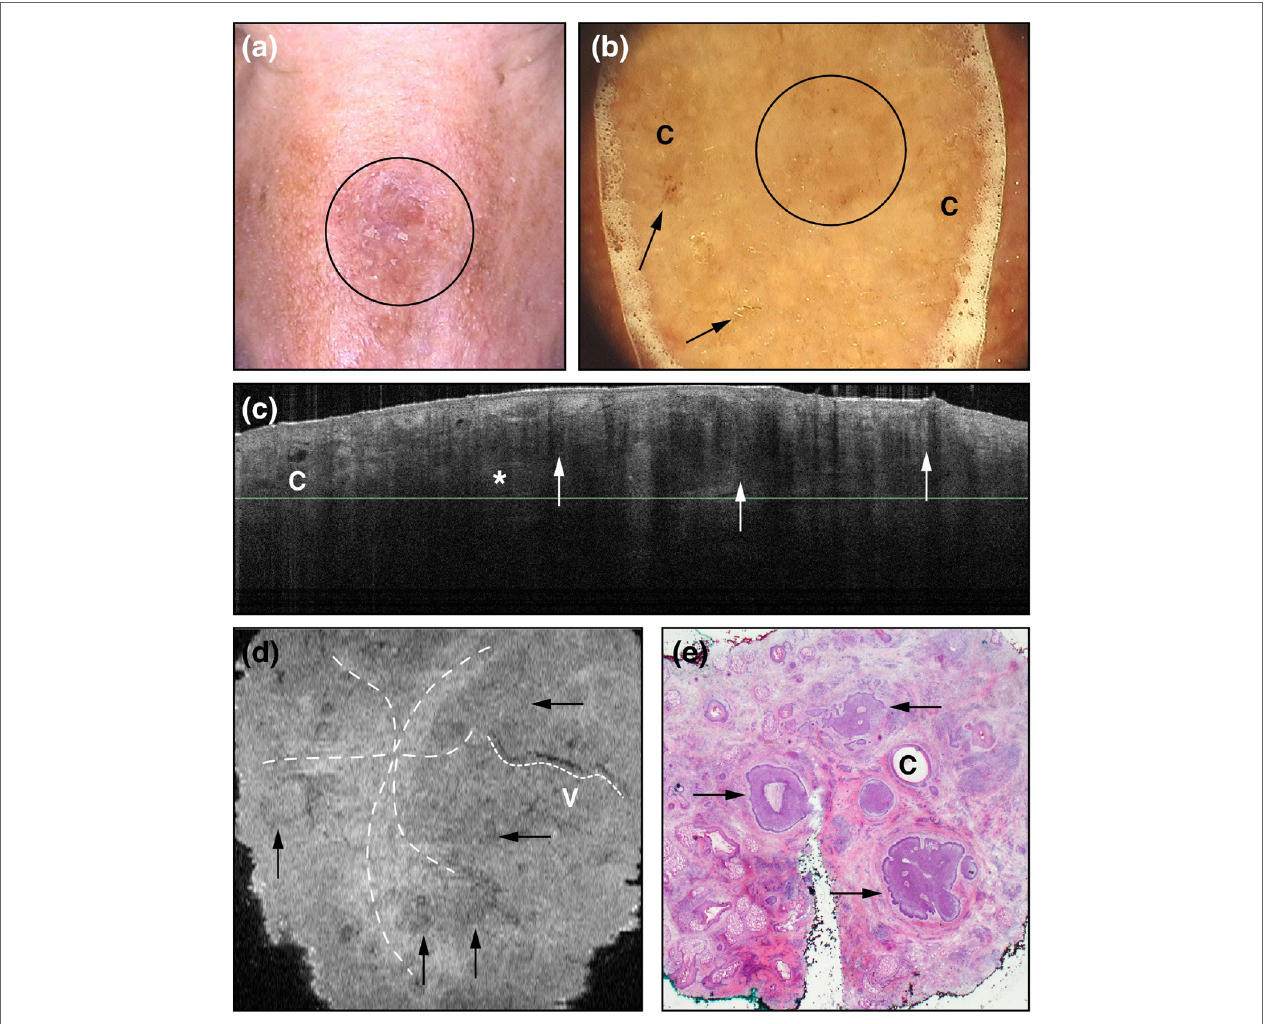
FigURe 5 | A demonstration of sclerosing basal cell carcinoma on the nose (circle) visualized with (a) clinical examination and (B) dermoscopy (“c” representing milia-like structures and the arrows pointing to erosions). Slide-mode optical coherence tomography is depicted in box (C) with nodules that are hyporeflective with hyporeflective rims (arrows) and hyperreflective peritumoral borders (asterisk) and a cyst marked “c.” In box (D) , the en-face mode gives information on the peritumoural fibers (star-shaped dotted line), vessels (marked “v” with smaller dotted line), and hyporeflective nodules with bright centers (arrows). Histopathology in panel (e) demonstrates peritumoural fibers surrounding tumors (arrows) and cysts marked with “c.” Permissions obtained to reprint from von Braunmühl et al.